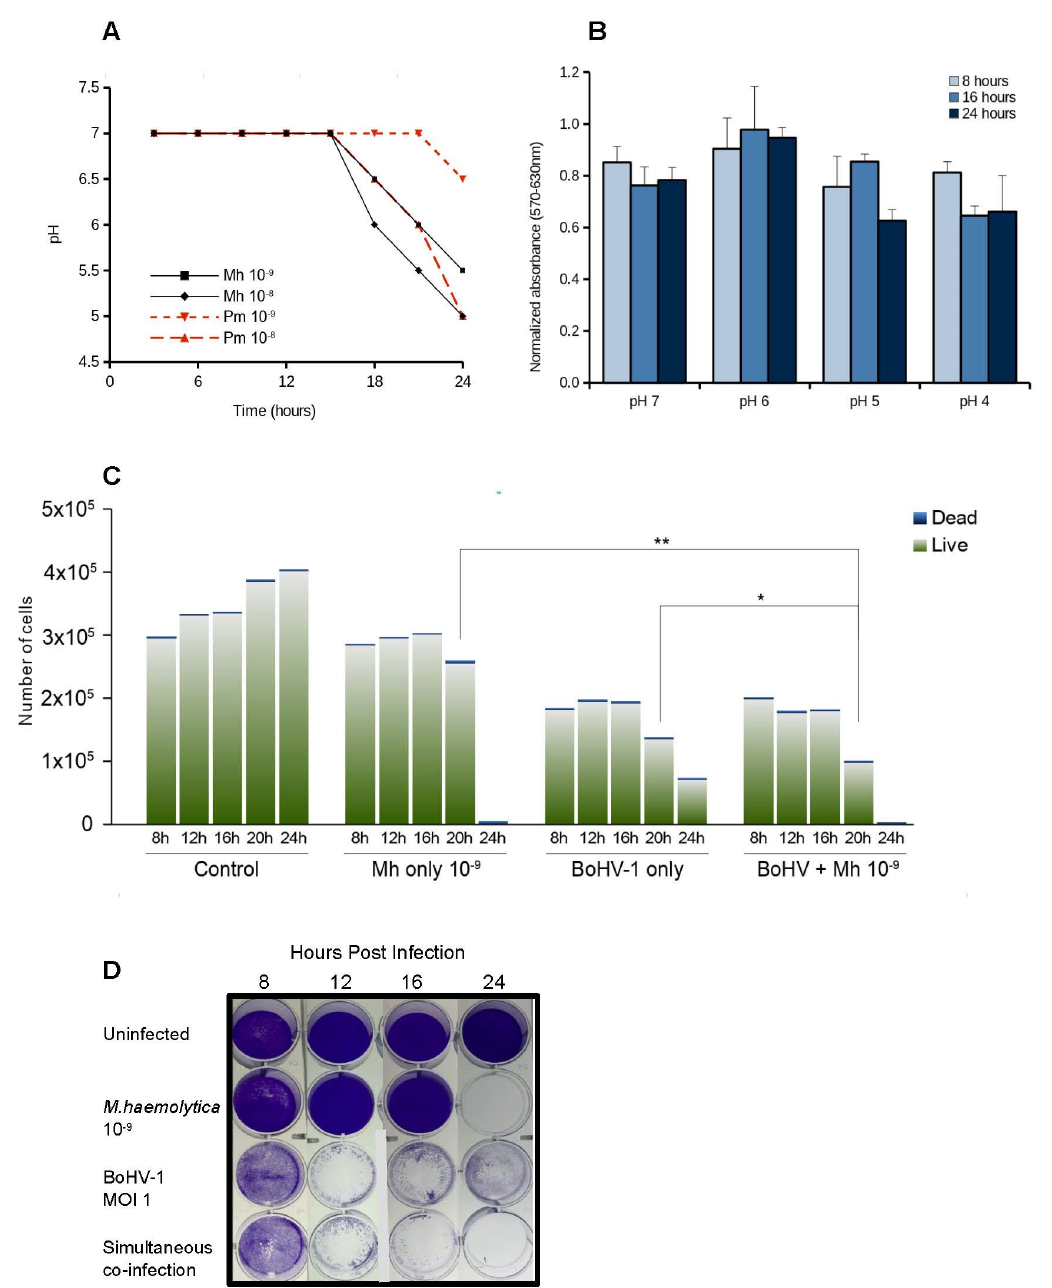
Figure 4. Acidification and MDBK cell viability. ( A ) Acidification during M. haemolytica and P. multocida growth in DMEM. ( B ) MDBK cell viability after culture at indicated pH. Cell viability was assessed by MTT assay. ( C ) Cell viability of MDBK cells infected with BoHV-1, M. haemolytica, or simultaneously with both agents was assessed at the indicated times by live/dead counts using bromophenol blue exclusion assay. Error bars are not shown due to the stacked nature of the plot. However, statistically significance between some samples’ means is indicated with asterisks (*, p < 0.05; **, p < 0.01). ( D ) MDBK cells were fixed and stained at the indicated times post infection with BoHV-1, M. haemolytica, or both to depict the viability of the cell monolayer. We further tested whether soluble bacterial factors were cytotoxic, thus indirectly reducing viral output. M. haemolytica was grown in tubes containing BHI or DMEM, or in DMEM in the presence of MDBK cells to about mid-log phase (8 h), based on LKT